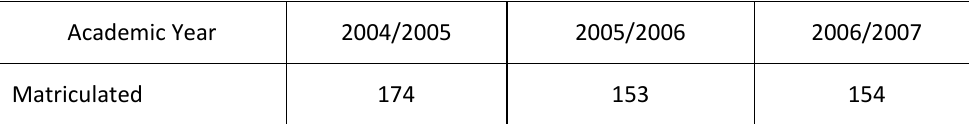
Table 1: ‘Signals and Systems’ subject background